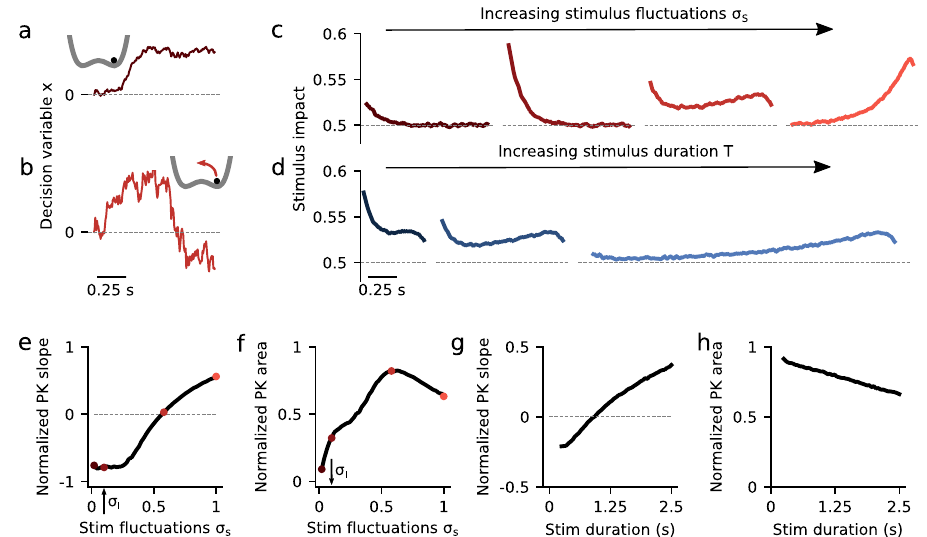
Fig. 2 Dynamics of evidence accumulation in the double well model. a , b Single-trial example traces of the decision variable for the DWM with weak ( a , σ S = 0.1) and intermediate ( b , σ S = 0.58) stimulus fl uctuations σ S . Transitions between attractors were only possible for suf fi ciently strong σ S (insets). c PKs for increasing values of σ S (from left to right, σ S = 0.02, 0.1, 0.58, and 1). d PKs for increasing values of stimulus duration T (from left to right, T = 0.5, 1, and 2.5 with σ S = 0.58). e , f Normalized PK slope and PK area as a function of σ S . Colored dots indicate the examples shown in panel c. The area peaks at the fl exible categorization and it vanishes for small σ S because choice is then driven by internal noise. g , h Normalized PK slope and area as a function of T with σ S = 0.58. As T increases, the DWM integrates a smaller fraction of the stimulus making the area decrease monotonically. Internal noise was σ I = 0.1 in all panels (see arrows in panels e and f